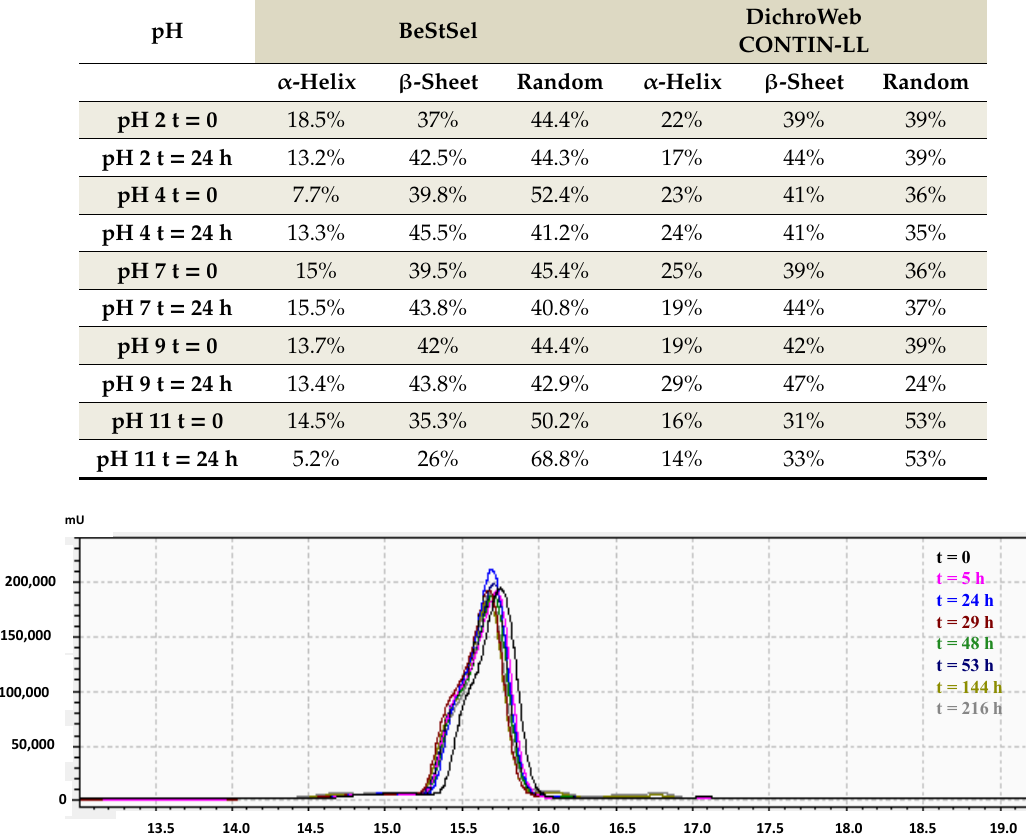
Figure 4. Stability in saline solution of RiLK1 determined by Reverse-Phase High-Performance Liquid Chromatography (RP-HPLC) on a C18 column. The peptide at final concentration of 50 µ M was incubated in the presence of NaCl (1M) until 9 day at 25 ◦ C. At each incubation time, the peptide solutions were recovered and analyzed by RP-HPLC. The solution at time 0 (t = 0) was used as control. The chromatograms are representative of three independent